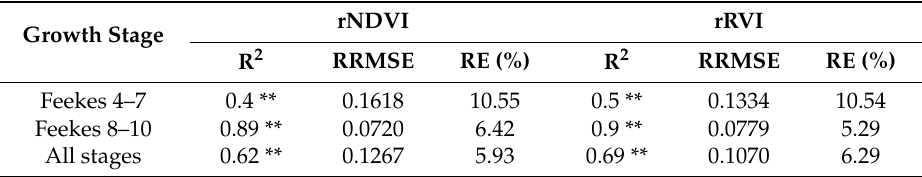
Table 7. Validation results of the GreenSeeker indices for estimating wheat yield at different growth